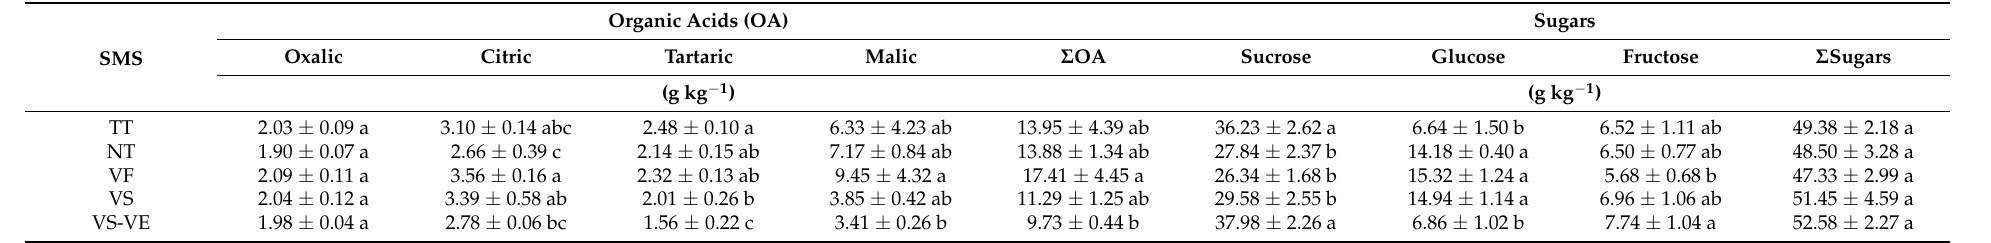
Table 8. Impact of different soil management strategies on organic acids and sugars content of almonds cv.